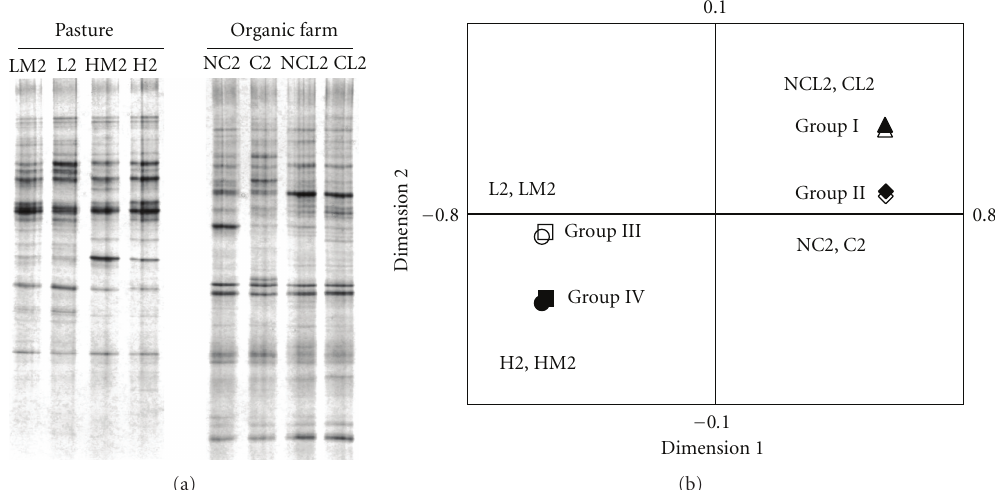
Figure 2: (a) DGGE gel of pooled PCR-amplified 16S rRNA genes from culture-dependent bacterial communities of organic farm and pasture from August to September 2004 and (b) ordination plots of dimensions 1 and 2 from NMDS analysis of CD DGGE data. Stress of the plot = 0.000053. Symbol designations are as described in Table 1.